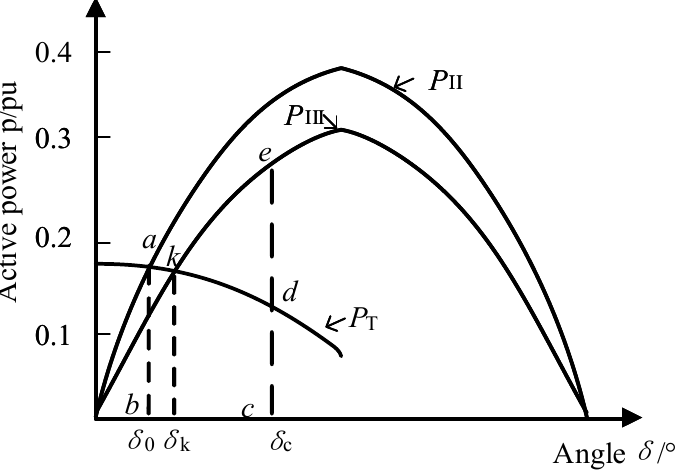
Figure 13. Power angle–power characteristic curve of doubly fed induction generator (8 m/s). The transient time-domain stability of the doubly fed induction generator is not only related to the magnitude of disturbance and the time to withstand disturbance, but also related to the system structure, power-flow situation, impedance and inertia of the generator, and many other factors, such as excitation regulator (AVR) and governor (GOV) automatic control device. In order to highlight the key research contents of this paper, only